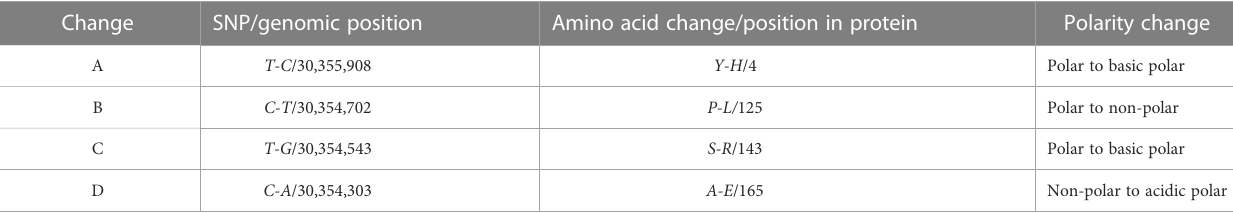
TABLE 1 Overview on the four types of changes observed in the amino acid sequence of DNA Primase Large subunit (PriL) of melon accession K18, carrying the ToLCNDV recessive resistance QTL on chromosome 11. We used melonomics genome version 4.0. Change SNP/genomic position Amino acid change/position in